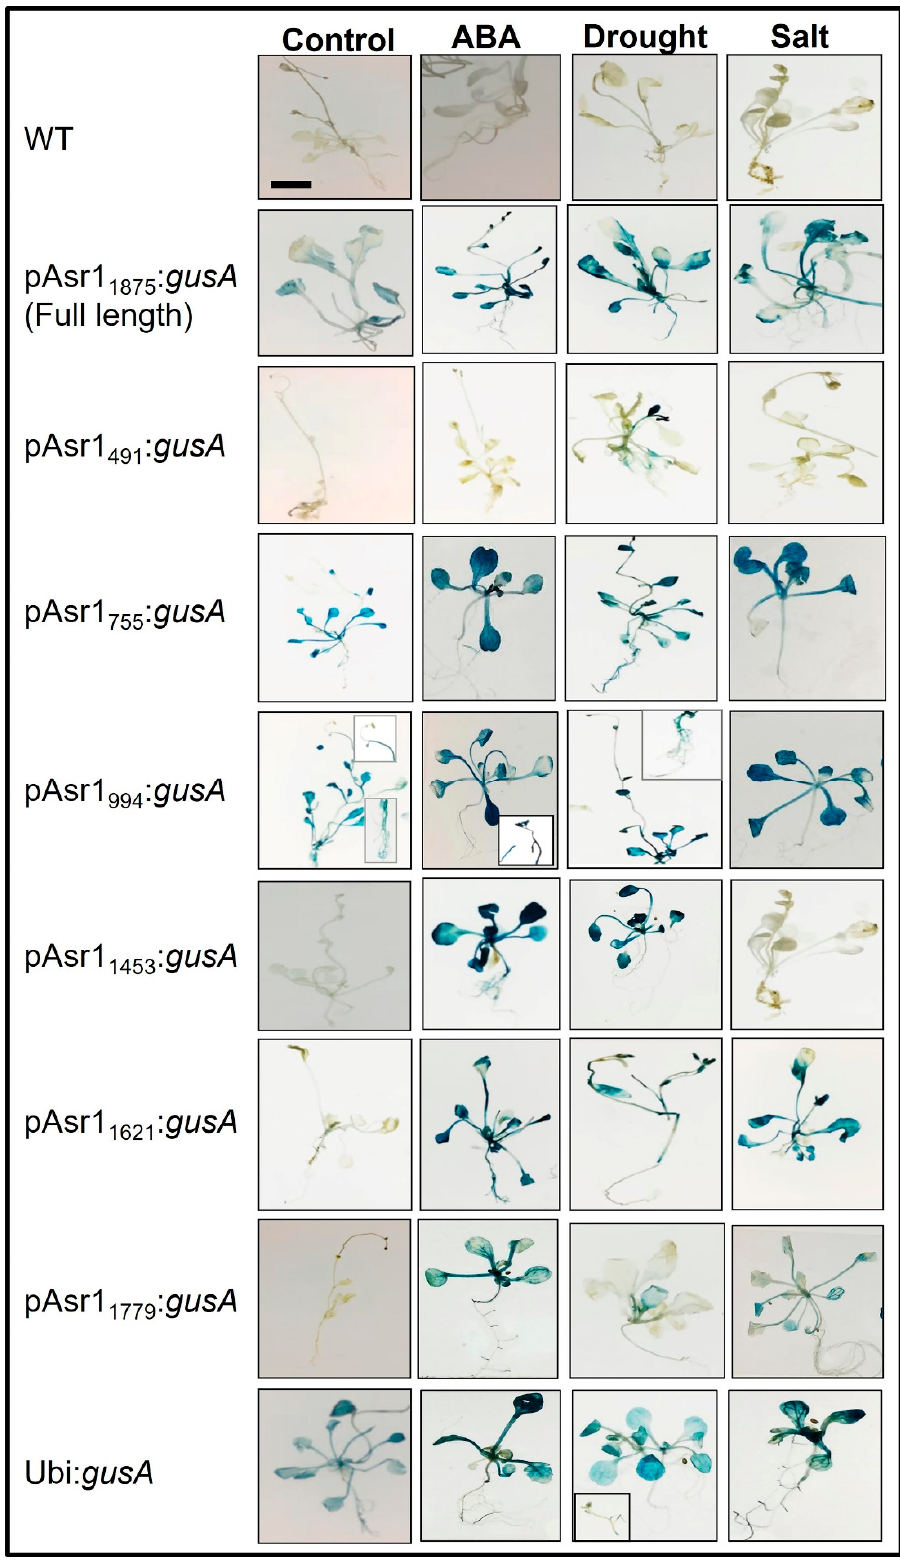
Figure 2. Histochemical GUS assay of Arabidopsis transgenics showing gusA gene expression under the control of pASR1 promoter constructs and constitutive maize ubiquitin promoter. Insets in plants with pAsr1 994 : gusA construct represent reproductive and root tissues at 10 × magnification. Scale bar = 1.0 cm.